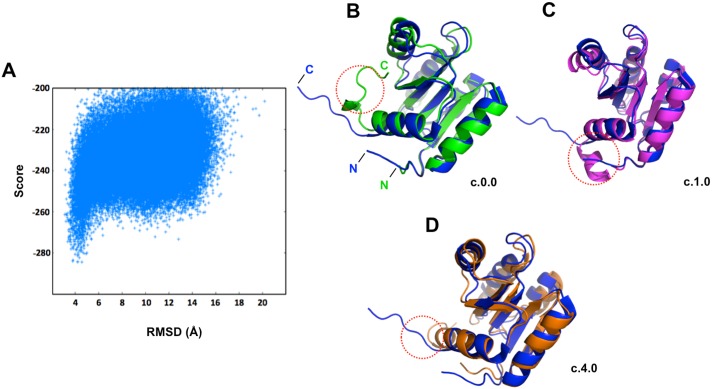
Structural determination of the ETR1-RD by Rosetta.(A) Plots of the Rosetta all-atom score versus Cα RMSD relative to the X-ray crystal structure (PDB code 1DCF). Representative structures of (B) the C.0.0 cluster (green), (C) the C.1.0 cluster (magenta) and (D) the C.4.0 cluster (orange) and the X-ray crystal structure (blue). The orange circles indicate the C-terminal structural difference in the structural modeling.